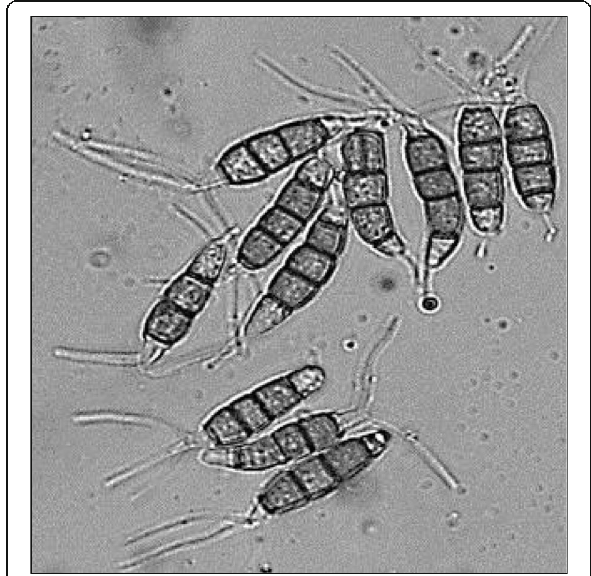
Fig. 1 Spore morphology of Pestalotiopsis microspora